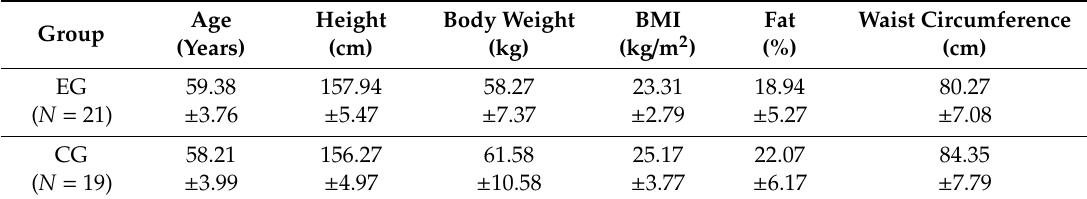
Table 1. Physical characteristics of participants in the study.